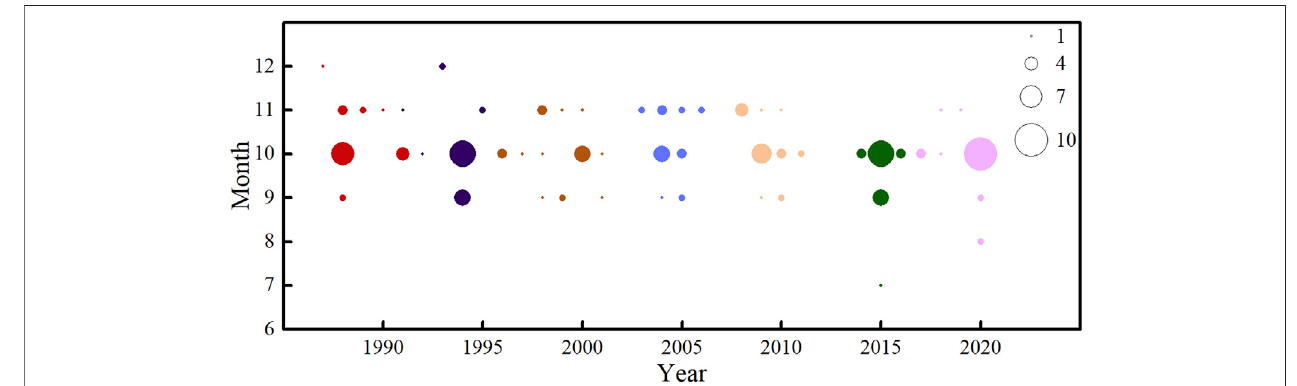
FIGURE 2 | Time phase statistics showing the temporal distribution of Landsat images of the study